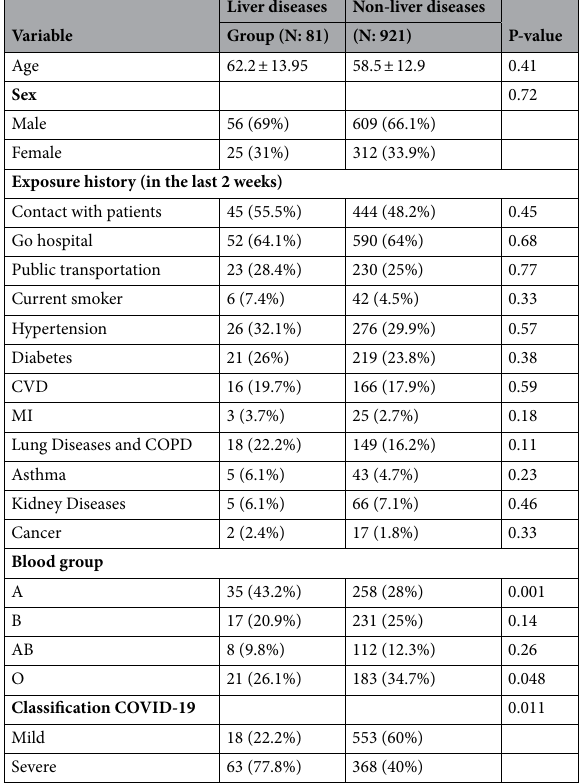
Table 1. Baseline characteristics of study population. MI myocardial infarction, COPD chronic obstructive pulmonary disease, CVD cardiovascular